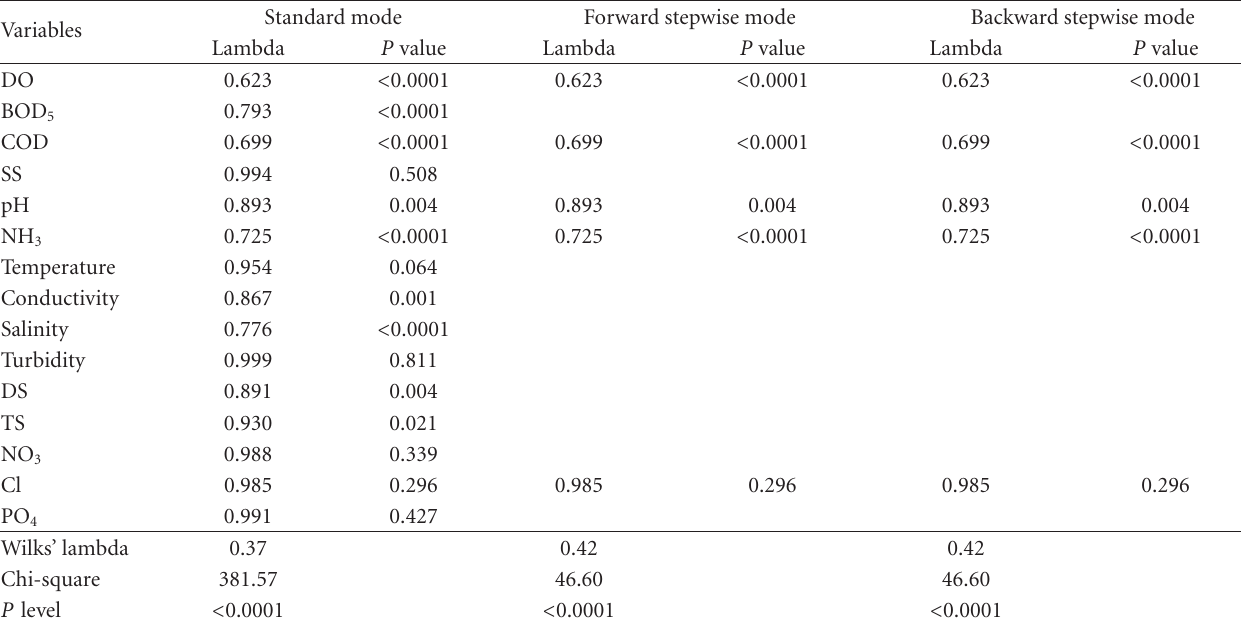
Table 2: Dry season classification functions for discriminant analysis (DA) of parameters in mg/L except for temperature, conductivity, and